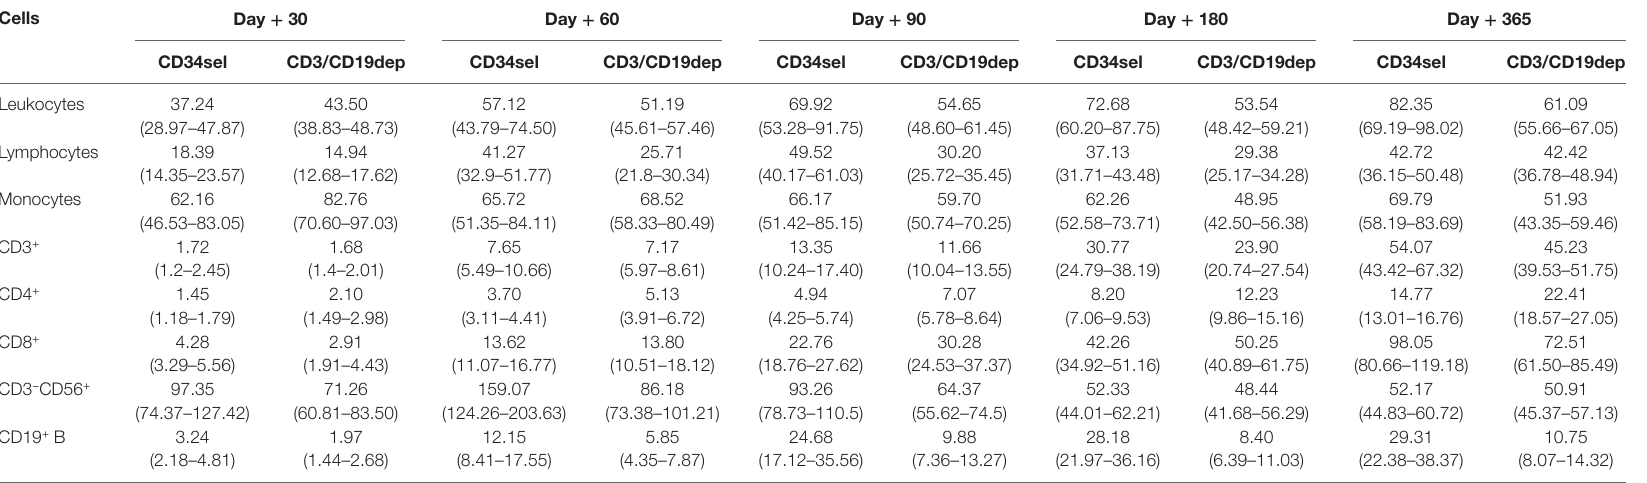
Table 3 | Predicted cells immune reconstitution (% norm) in patients who received reduce-intensity conditioning regimen. cells